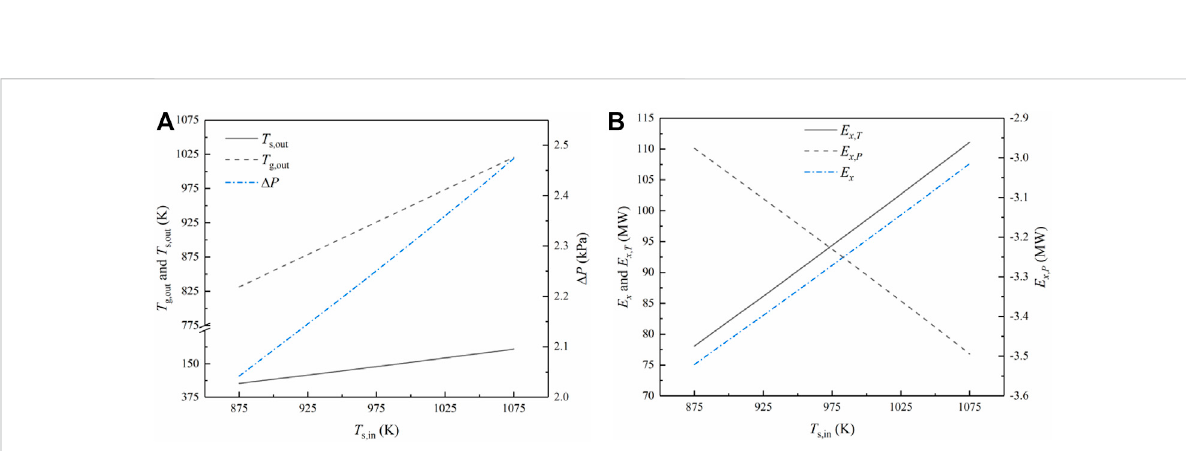
E x , T , pressure exergy E x , P and income exergy E x with T